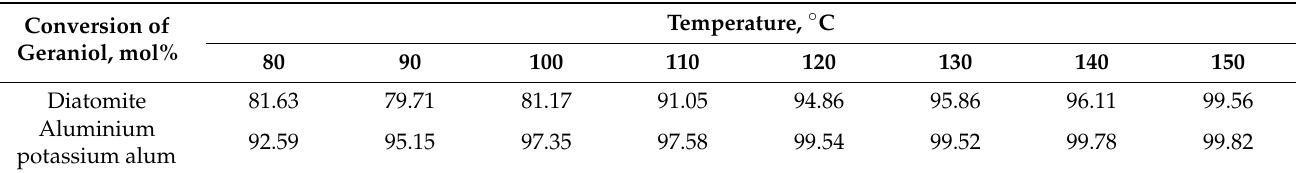
Table 4. The influence of temperature on the conversion of